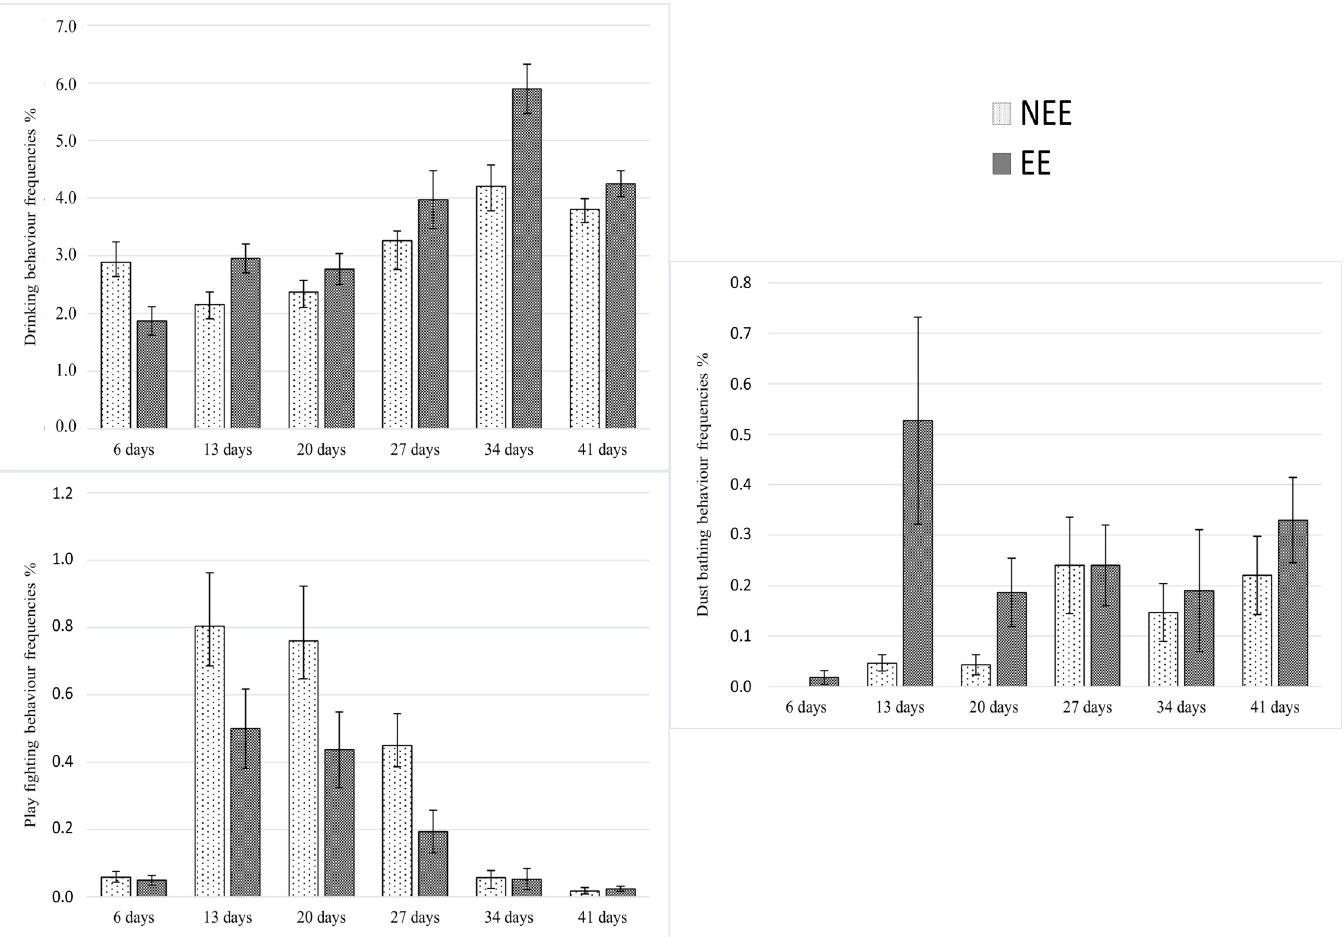
Fig 3. The effect of age on the frequencies (%) of behaviours performed in the NEE and EE treatments. (A): Drinking, (B): Dust bathing, (C): Play fighting. See more information in the supplementary material.